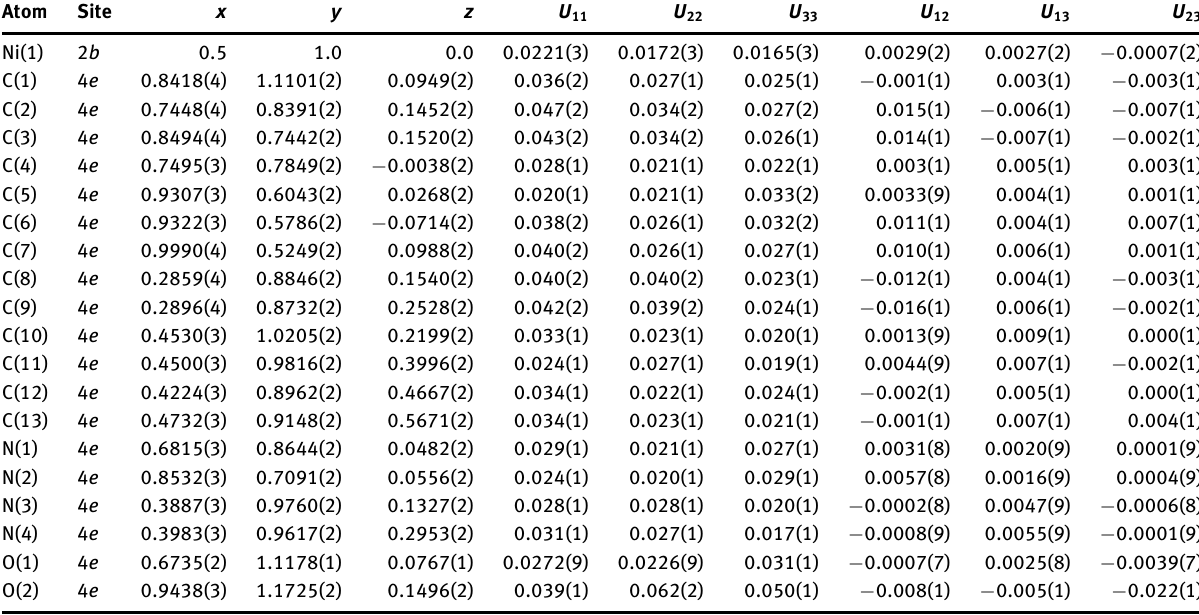
Table 3: Atomic displacement parameters (Å 2